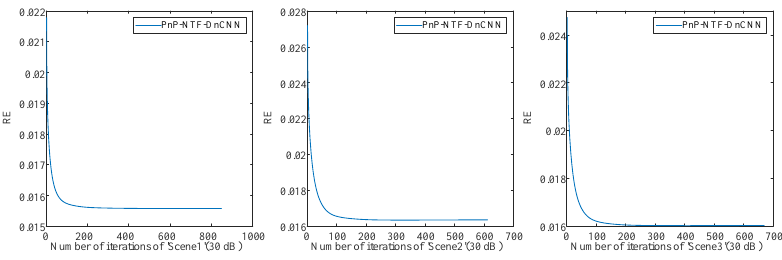
Figure 8. Iterations of RE with DnCNN.